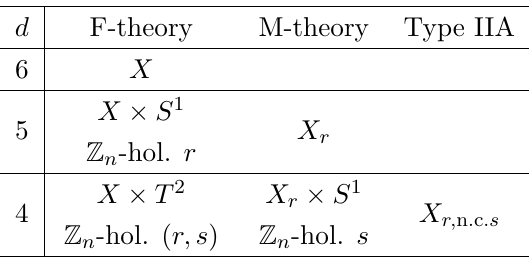
Table 1 . The duality between F-theory, M-theory and Type IIA string theory with Z n